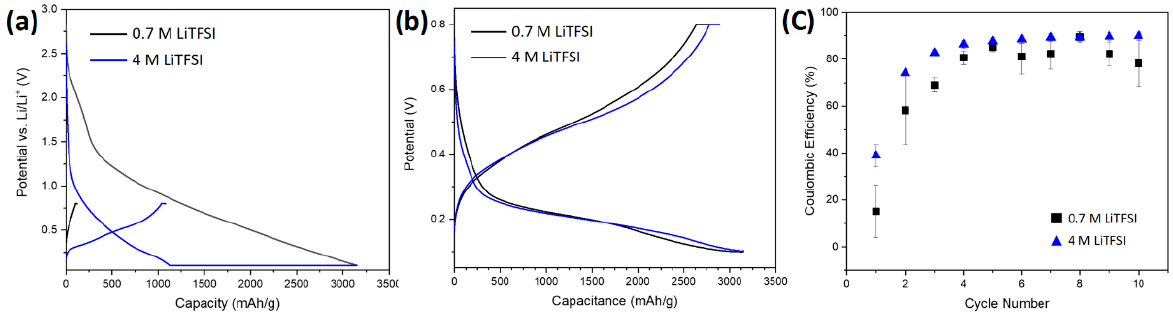
Figure 15. Decomposition mechanism of an exemplary chosen LiTFSI molecule. Shown are trajectory screenshots as well as the effective Lewis structures of the visible parts. Short-lived intermediates or transition states might correspond to unusual Lewis structure patterns.